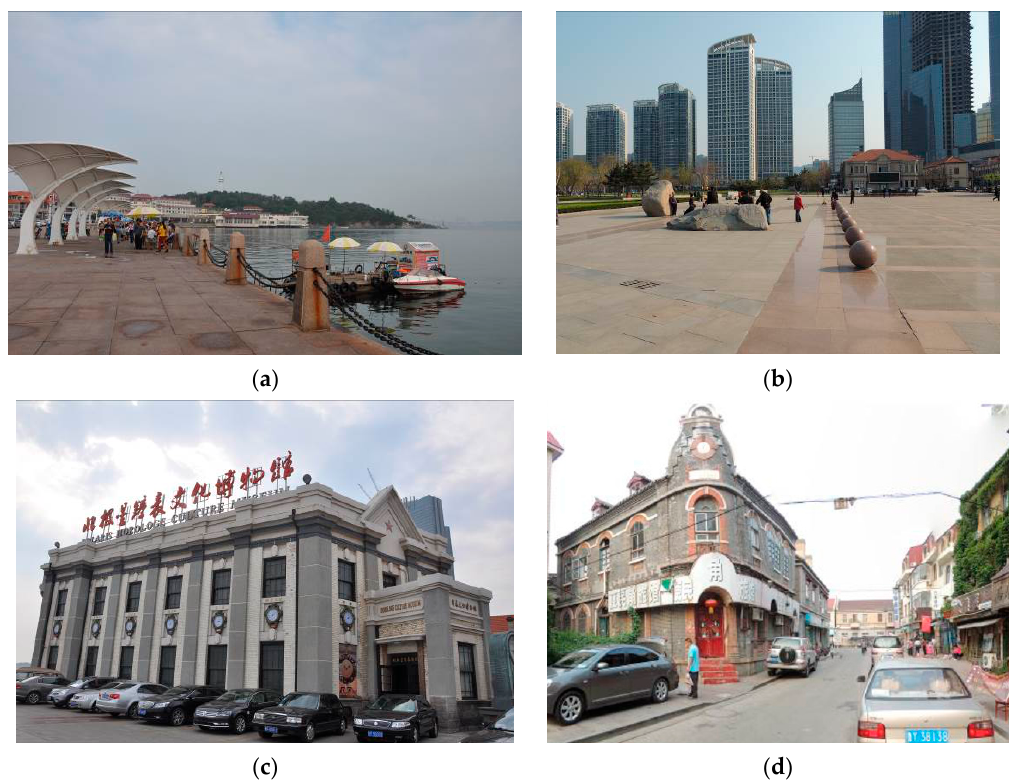
Figure 3 . A glimpse of the Yantai Hill area. They show ( a ) the artificial terraces of coast, ( b ) Binhai Square, ( c ) Polaris Watches Cultural Museum and ( d ) an old building on Haian Street.